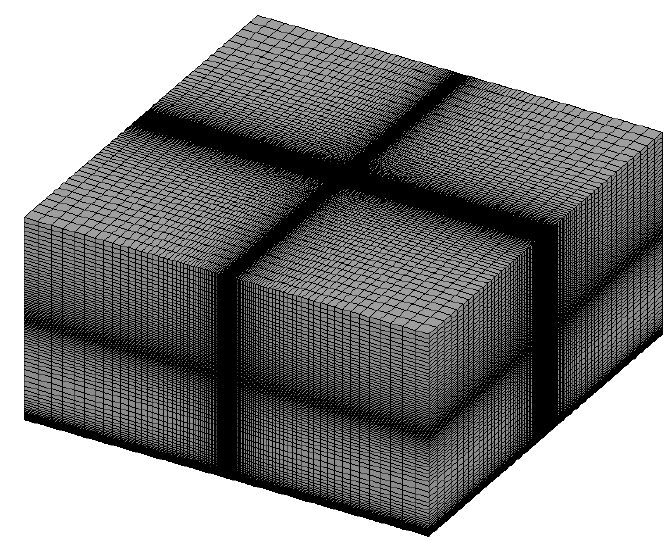
Figure 3. Diagram of 3D non-uniform cells.